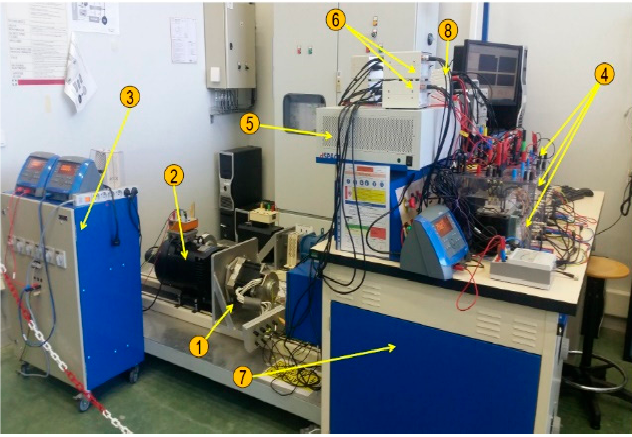
Figure 11. Test bench SRM-DC machine.